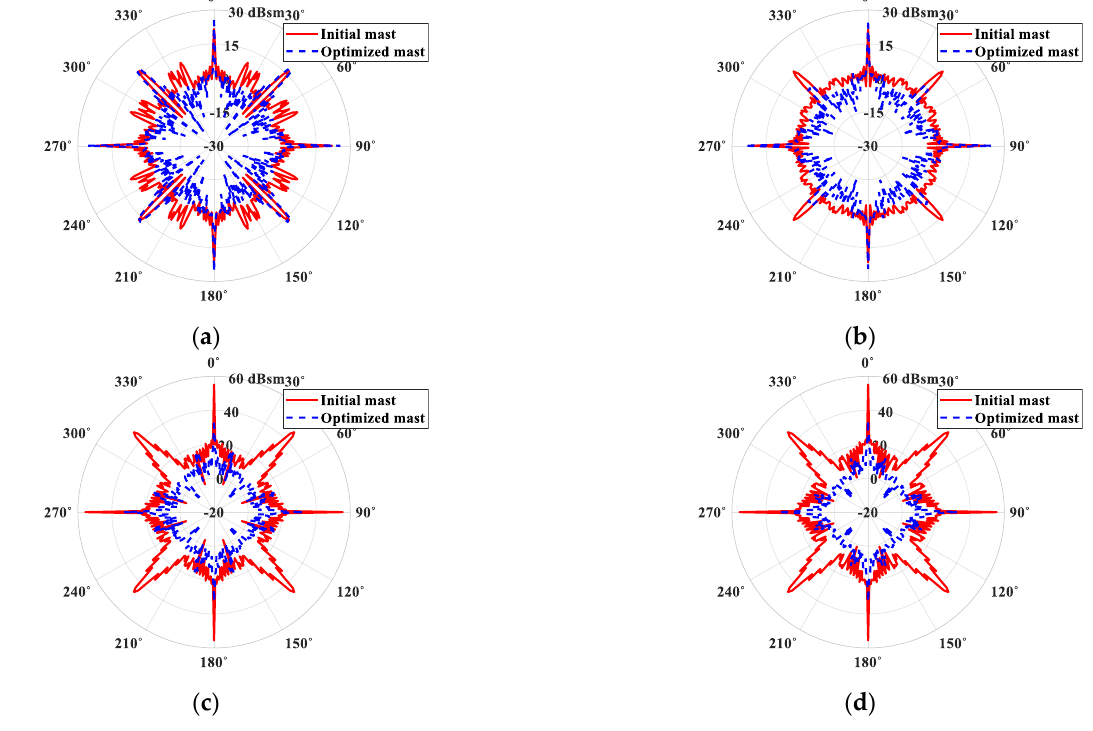
VV polarization in the L-band, ( c ) HH polarization in the S-band, ( d ) VV polarization in the S-band, ( e ) HH polarization